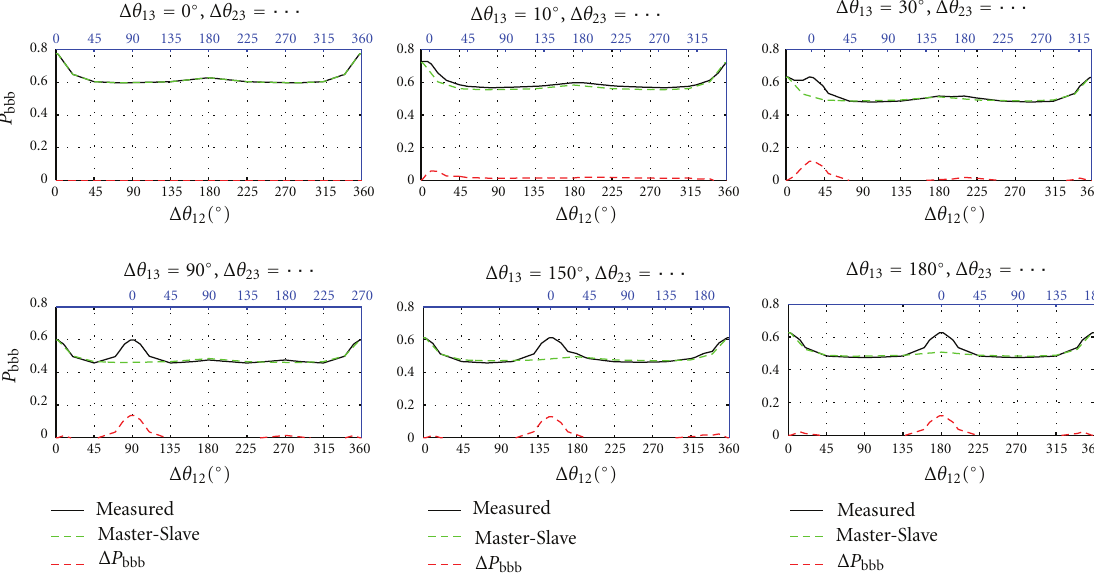
Figure 9: “bad bad bad” state probabilities ( P bbb ) of three satellites for di ff erent azimuth angle separations Δ θ from measurements and recalculated with Master-Slave. The elevation angles are φ 1 = φ 2 = φ 3 = 15 ◦ , where the “bad” state probability of each individual satellite is P = 0 . b